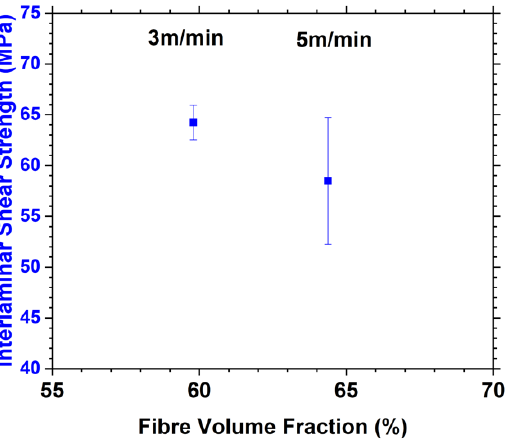
Figure 11. Interlaminar shear strength test results of the UD-CFRP plates.